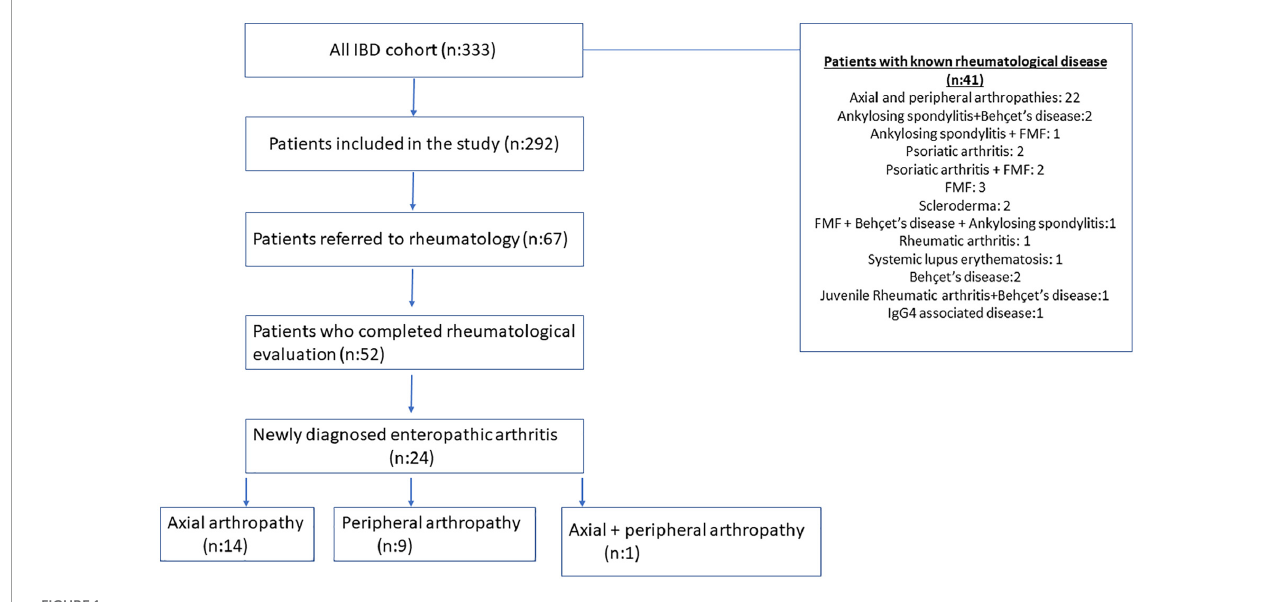
FIGURE1 Flow charts for patients with inflammatory bowel disease (IBD).